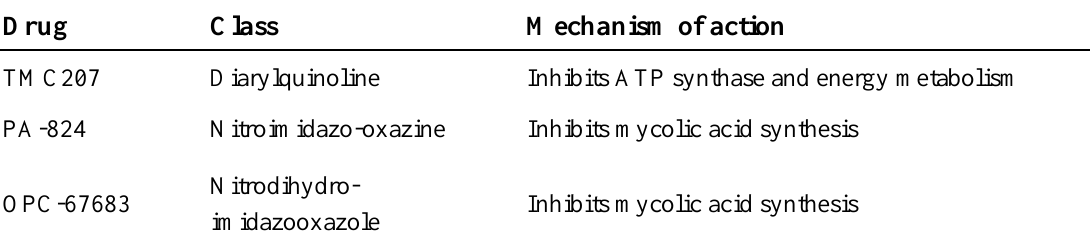
Table 5. Novel anti-TB drugs currently in Phase II clinical